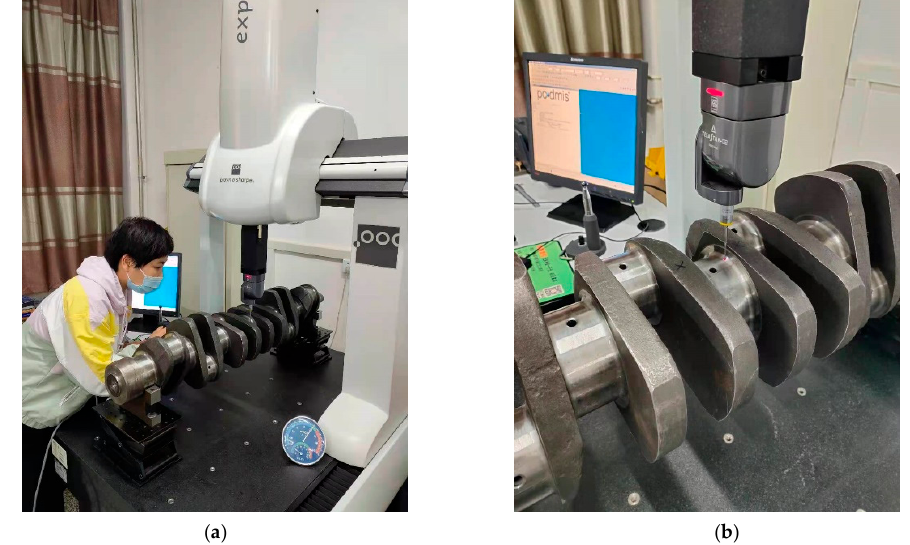
Figure 16. CMM platform. ( a ) Overall display image of CMM. ( b ) Partial display image of CMM.